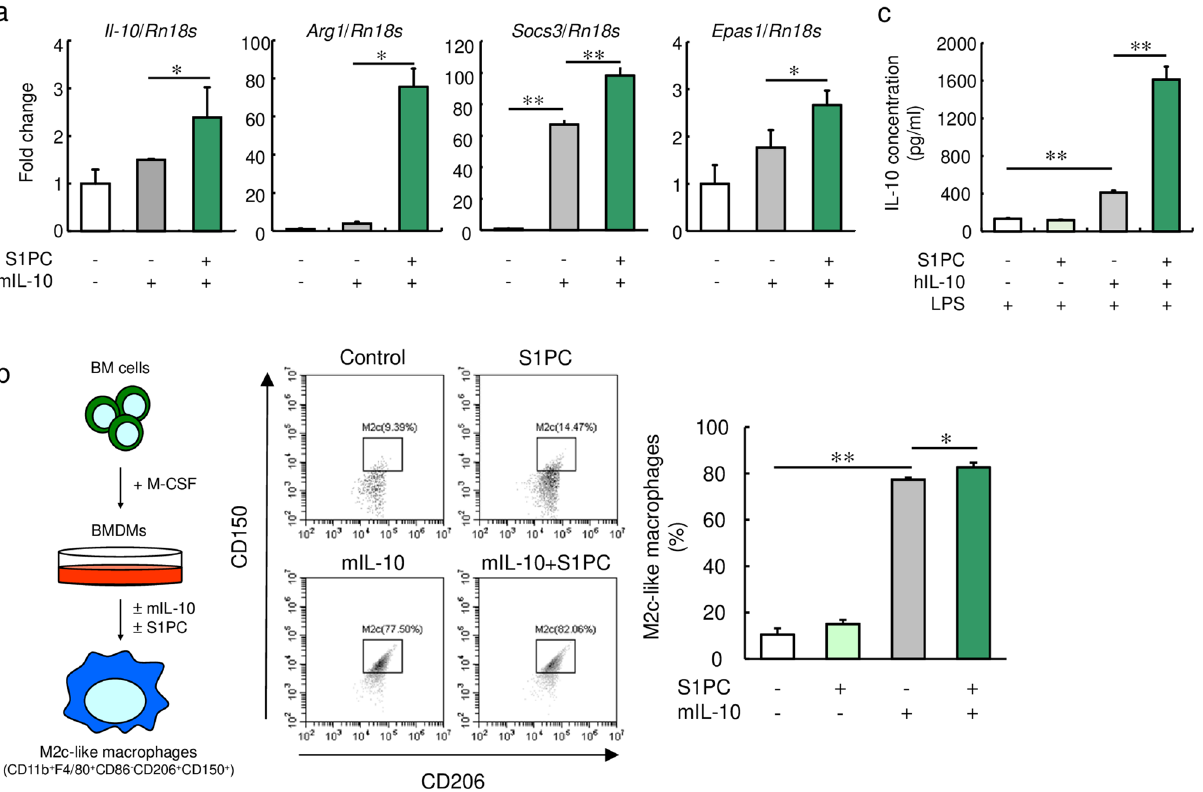
Figure 2. Effect of S1PC on IL-10-induced macrophage polarization in M-CSF-induced BMDMs. ( a ) M-CSF- induced BMDMs were treated with S1PC (300 µM) in the presence of mIL-10 (20 ng/mL) for 48 h. The relative levels of M2 macrophage marker genes ( Il-10 , Arg1 , Socs3 , and Epas1 ) were analyzed using qRT-PCR. ( b ) M-CSF-induced BMDMs were treated with S1PC (300 µM) in the presence or absence of mIL-10 (20 ng/mL) for 48 h. The population of M2c-like macrophages (CD11b + , F4/80 + , CD86 - , CD206 + , and CD150 + cells) were analyzed by flow cytometry. ( c ) M-CSF-induced BMDMs were treated with S1PC (300 µM) in the presence or absence of hIL-10 (20 ng/mL) for 48 h. Then, they were washed with PBS and treated with LPS (50 ng/mL) for 6 h. The amounts of IL-10 secreted into the culture media were determined using ELISA. Data are shown as mean + SD. Data are representative of three independent experiments. Statistical differences were determined using Bonferroni’s multiple comparison test (* p < 0.05 and ** p <